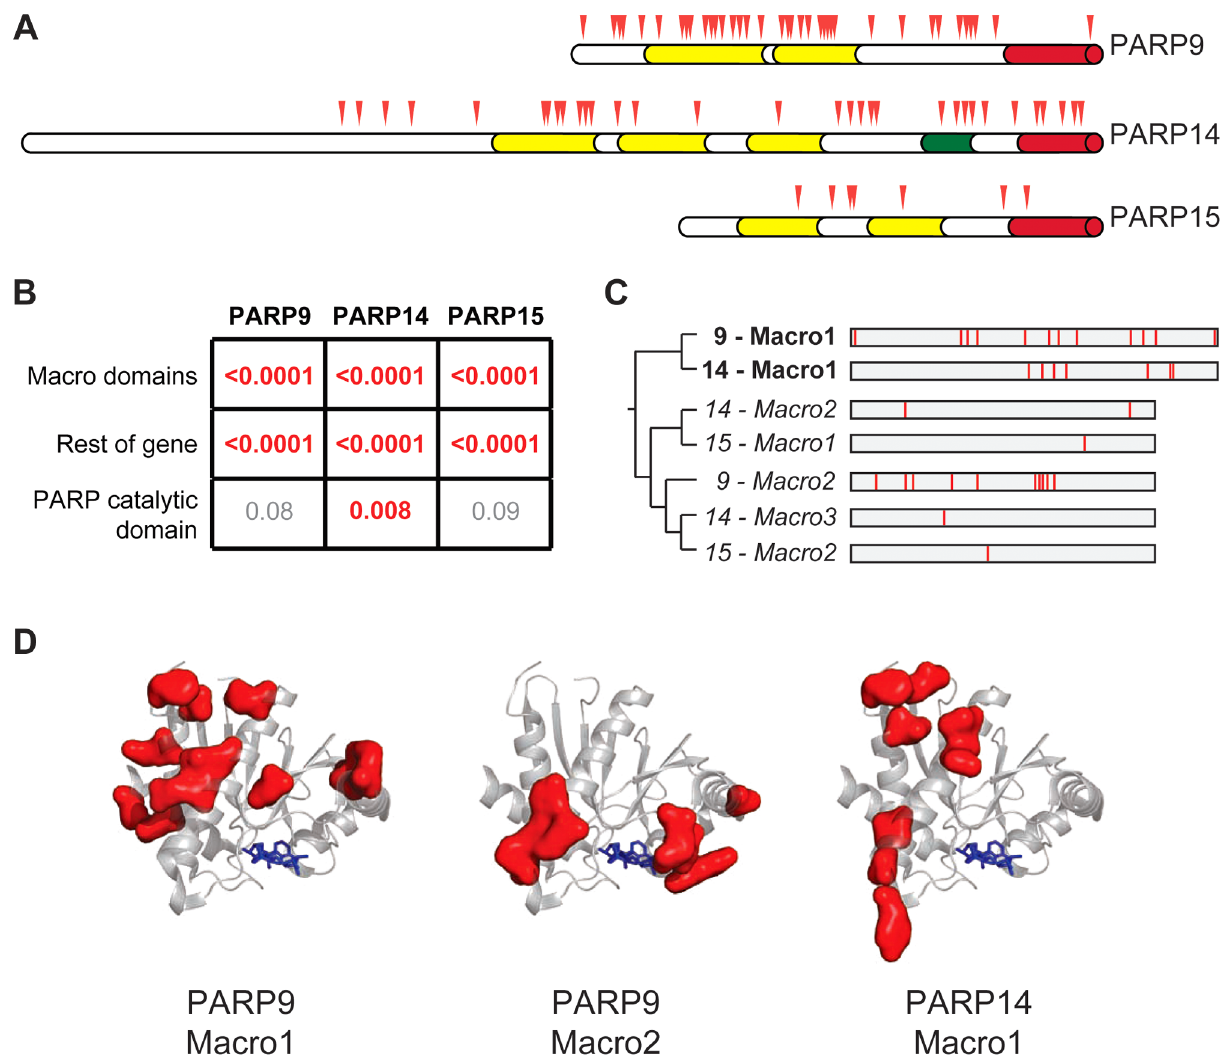
Figure 3. Widespread distribution of positive selection in macro-PARP genes. (A) The domain structure of each macro-PARP gene is shown with domain colors as in Figure 1A. Codons evolving under recurrent positive selection are marked with red triangles as in Figure 2 (see also Tables S6-S8). (B) P–values derived from PAML tests of positive selection on all sequenced macro-PARP orthologs using either macrodomains alone, the entire gene minus the macrodomains or just the catalytic domain. Values in red indicate strong evidence of positive selection, while those in grey indicate a lack of statistically significant evidence for positive selection. (C) Phylogenetic tree of individual macrodomains from macro-PARPs, rooted using human MacroD2 as an outgroup. Macrodomains in italics lack a C-terminal extension found in most macrodomains and lack one or more of the putative catalytic motifs required for ADP-ribosylhydrolase activity [16] (Figure S5). This suggests these macrodomains may be able to recognize, but are unlikely to catalyze removal of, ADP-ribosylation. To the right is a schematic of each macrodomain with positively selected residues indicated in red (posterior probabilities greater than 0.95) (see also Alignment S3). (D) Location of positively selected sites in PARP macrodomains mapped on to the structure of the first macrodomain from PARP14 in complex with ADP-ribose (PDB code: 3Q6Z)[48]. ADP-ribose is shown as blue sticks. Residues shown as red surfaces are those that have evolved under positive selection in the indicated macrodomain.